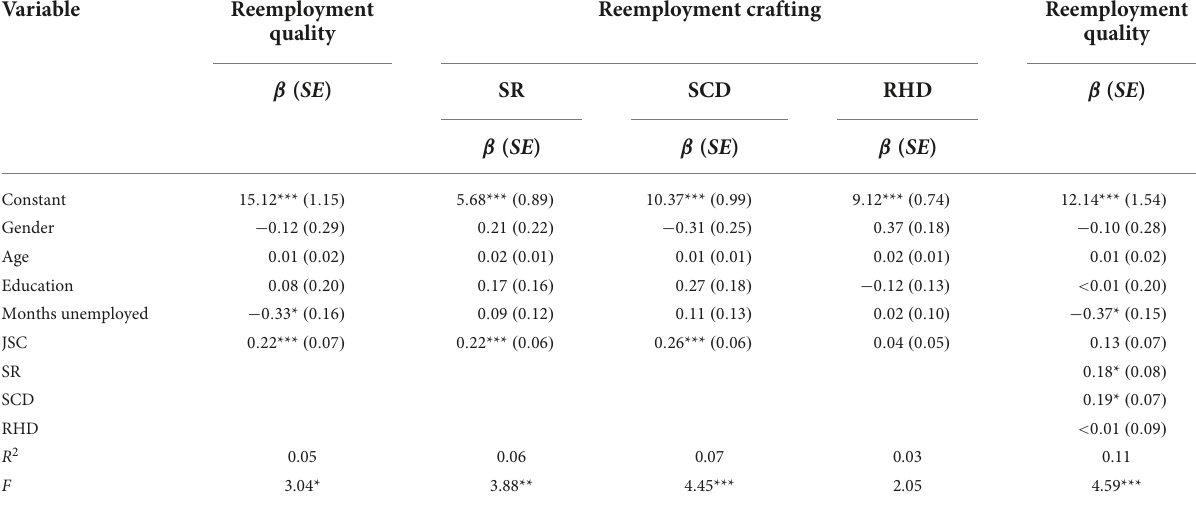
TABLE 3 The mediation model of reemployment crafting between JSC and reemployment quality.